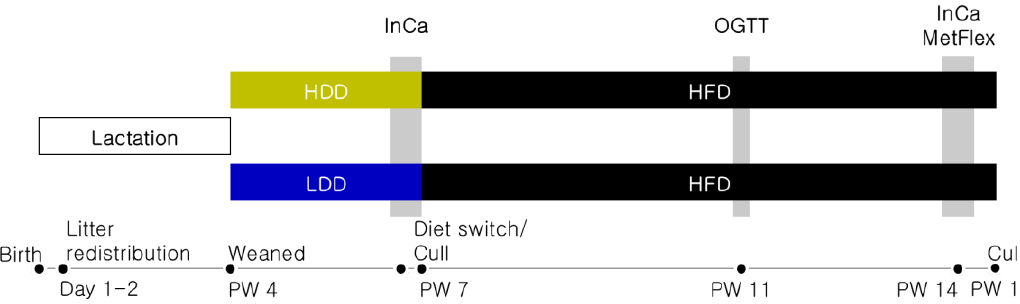
Figure 1. Experimental design. Female and male mice fed standard rodent chow were time-mated and their offspring were redistributed at postnatal day 1–2 to standardized nests. At the end of postnatal week (PW) 3, after weaning, the pups were individually housed and fed either a highly-digestible starch diet (HDD) or a lowly-digestible starch diet (LDD). In PW 6, all of the mice had their basal metabolic phenotype assessed by indirect calorimetry (InCa). A subgroup of animals of each diet and sex was dissected at the end of PW 6 to further assess the direct effects of the post-weaning dietary intervention. The remaining mice were switched to a high-fat diet (HFD) from PW 7 onwards to study metabolic programming in an obesogenic environment. In PW 11, mice underwent an oral glucose tolerance test (OGTT). At the end of HFD-feeding, basal metabolism was measured, and metabolic flexibility (MetFlex) was assessed by InCa. Mice were culled at the end of PW 15, and their blood and tissues were harvested for further analysis.